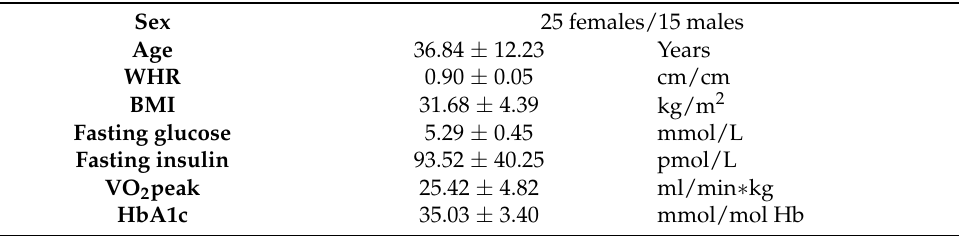
Table 1. Participant